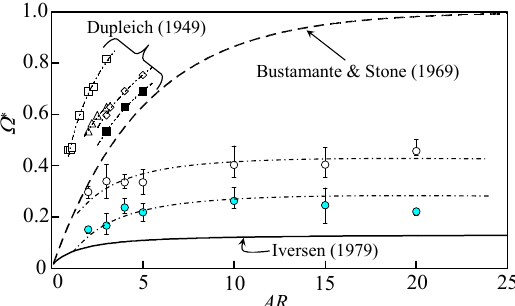
Fig. 7 Reduced rotating rate Ω * of a tumbling plate versus aspect ratio AR at depth-to-width ratio λ = 0.3, C = 3.86 × 10 2 . I * = 7.73, Re ( V )=2.83 × 10 3 ( Re = 2.0 × 10 3 – 2.7 × 10 3 ). I * = 7.73, Re ( V )=2.83 × 10 3 ( Re = 2.0 × 10 3 – 2.7 × 10 3 ). I * = 24.4, Re ( V )=5.08 × 10 3 ( Re = 2.6 × 10 3 – 3.4 × 10 3 ). I * = 24.4, Re ( V )=5.08 × 10 3 ( Re = 2.6 × 10 3 – 3.4 × 10 3